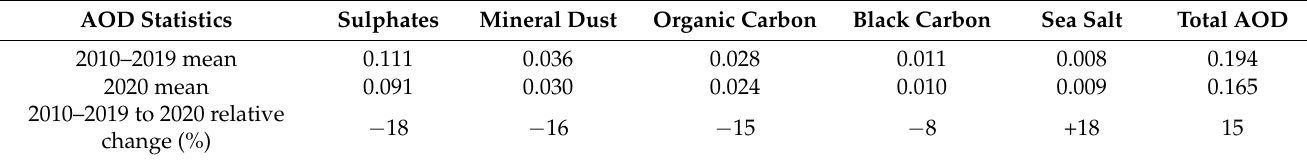
Table 2. Statistics of AOD components (at 550 nm) obtained from MERRA-2 reanalysis between March and June over Poland. AOD